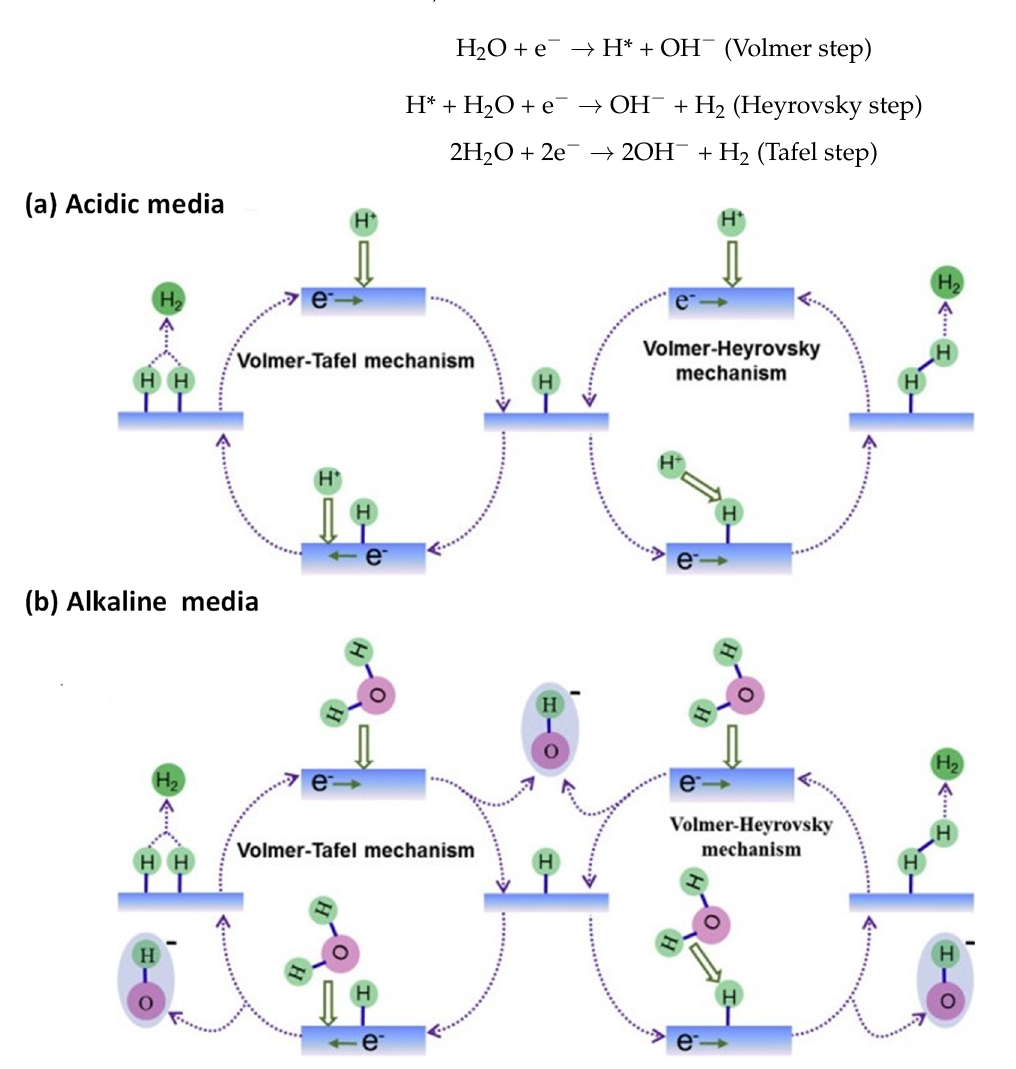
Figure 1. Schematic illustration of the hydrogen evolution reaction mechanism in acidic and alkaline media [23].